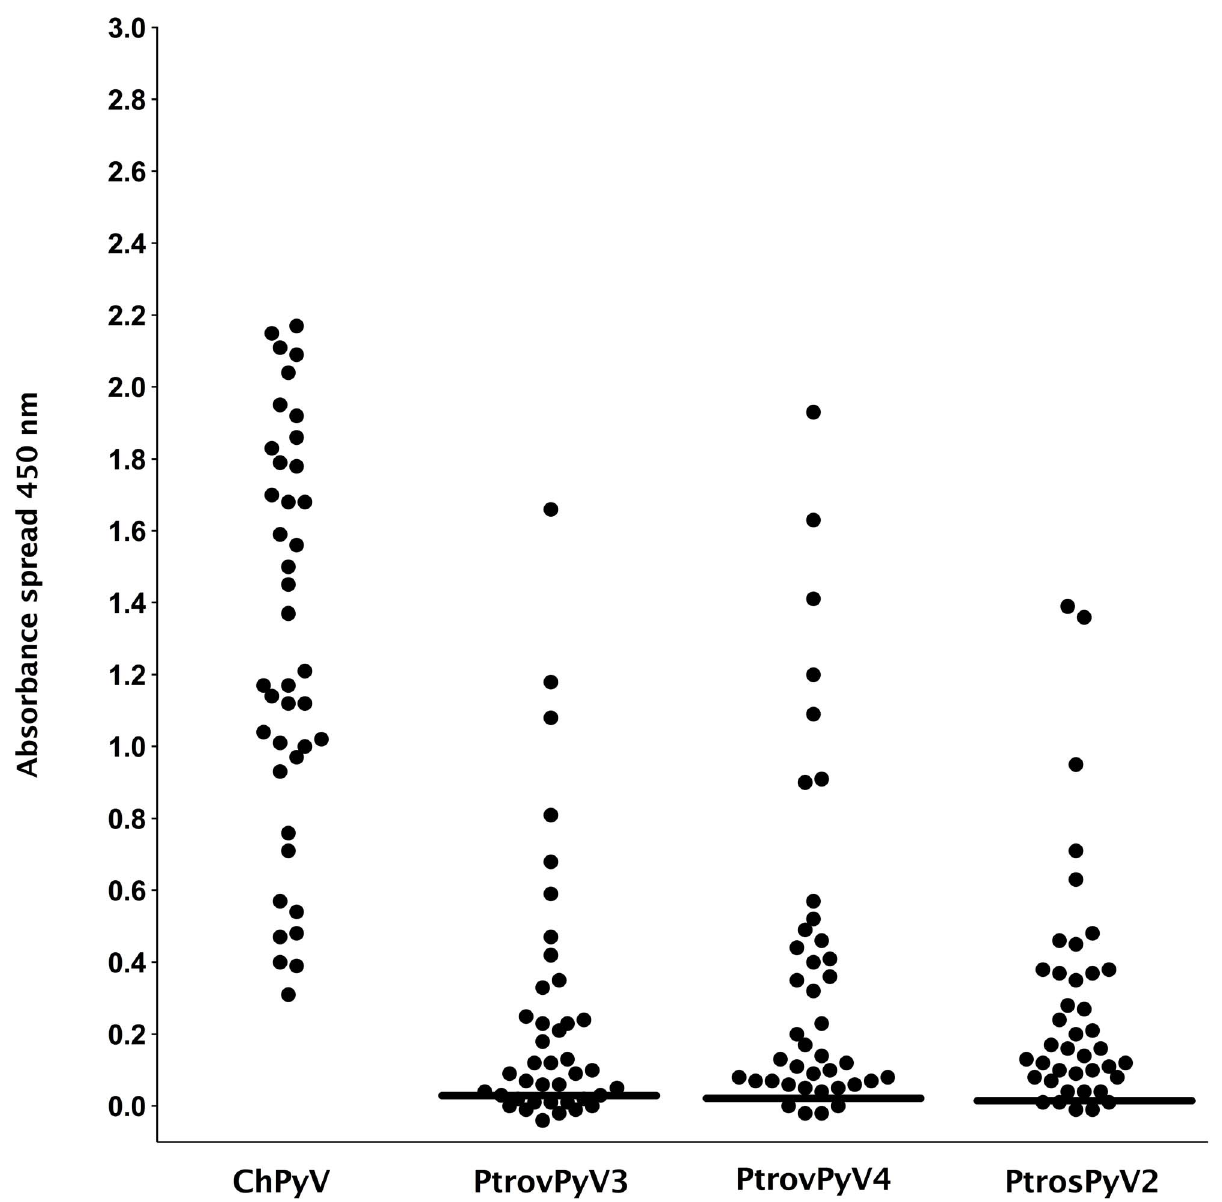
Figure 2. Reactivity of chimpanzee plasma samples to VP1 proteins of chimpanzee polyomaviruses. Antibody reactivity was assessed against the 4 chimpanzee polyomaviruses ChPyV, PtrovPyV3, PtrovPyV4 and PtrosPyV2 using plasma of 40 chimpanzees. Samples were analysed for seroreactivity with a capsomer-based IgG ELISA using the VP1 major capsid protein of the above polyomaviruses as antigens. The spread of absorbance measurement is shown with black dots, and cut-off values (COVs) are depicted with solid lines (PtrovPyV3: 0.028; PtrovPyV4: 0.023; PtrosPyV2: 0.013). A COV for ChPyV could not be calculated because all OD 450 values were . 0.3.